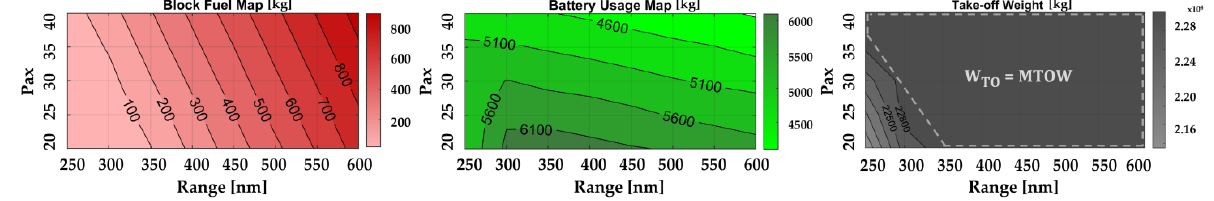
Figure 13. Block fuel (left), battery mass (centre), and take-off weight W TO (right) for the missions inside the pax – range diagram. inside the pax–range